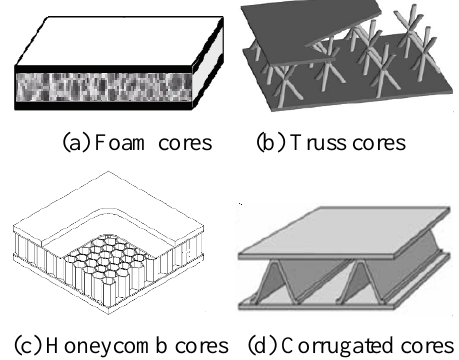
Fig. 1. Sandwich panels with the different